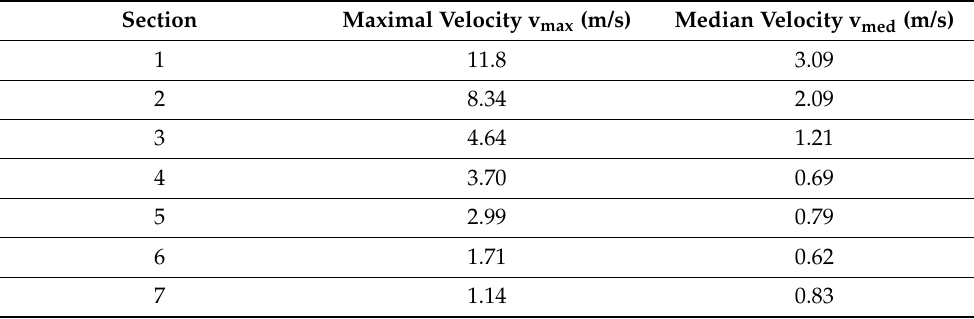
Table 2. Evaluation of maximal and median airflow velocities in nasal passages, measured in 7 nasal regions identified on CT